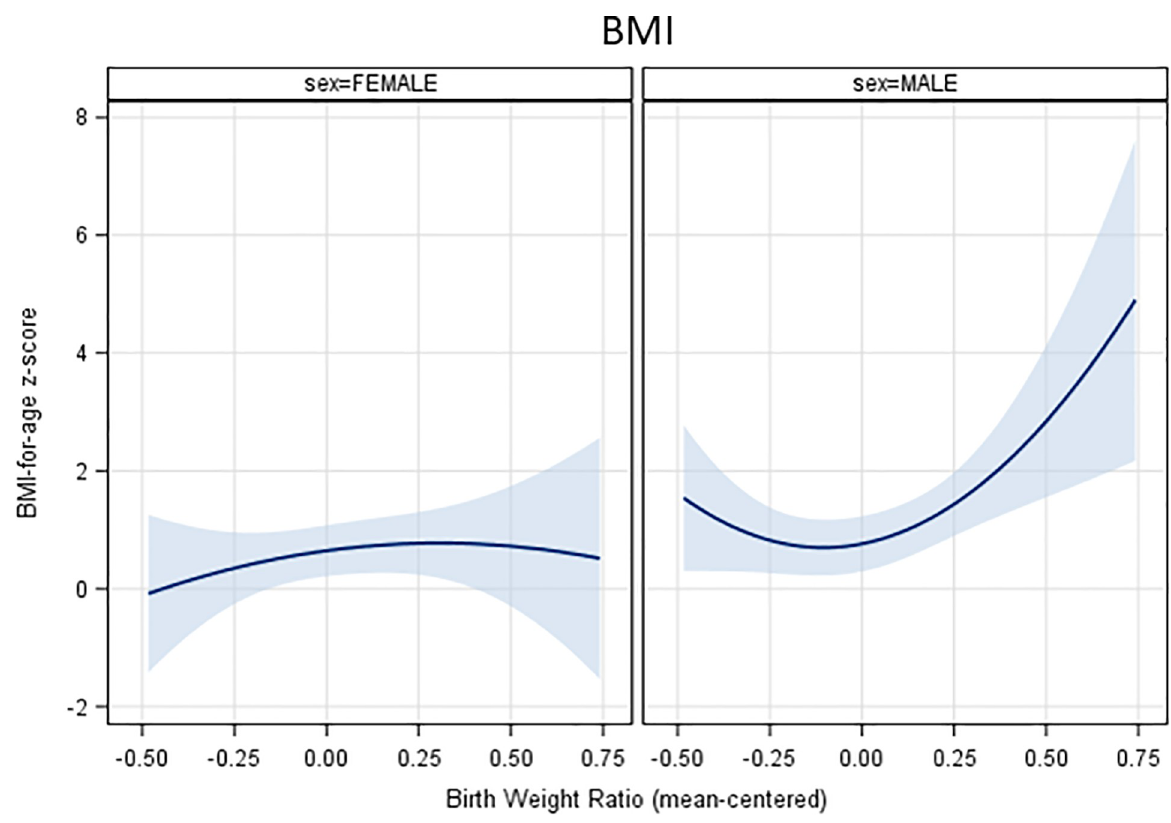
Fig 2. Fitted curves between birth weight ratio and zBMI in boys and